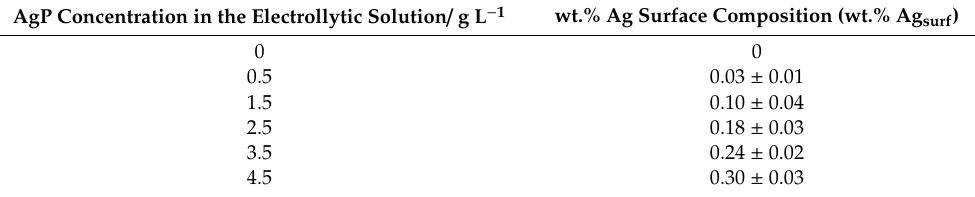
Table 2. Results obtained by EDX of the content of Ag on the surface (wt.% Ag surf ) of the Zn/AgP coatings formed from solutions with different concentrations of AgP.